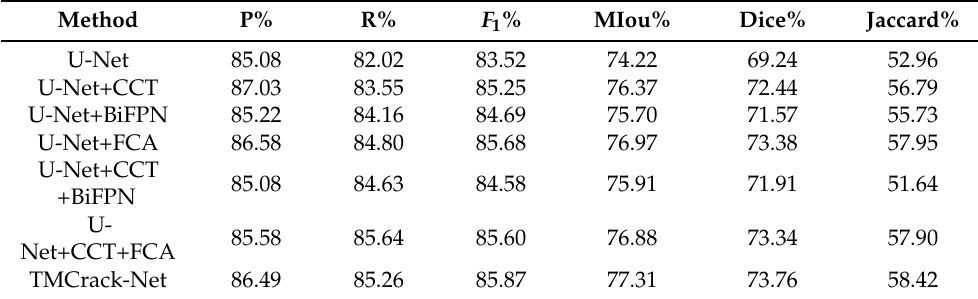
Table 8. Ablation study on TMCrack for the each module.